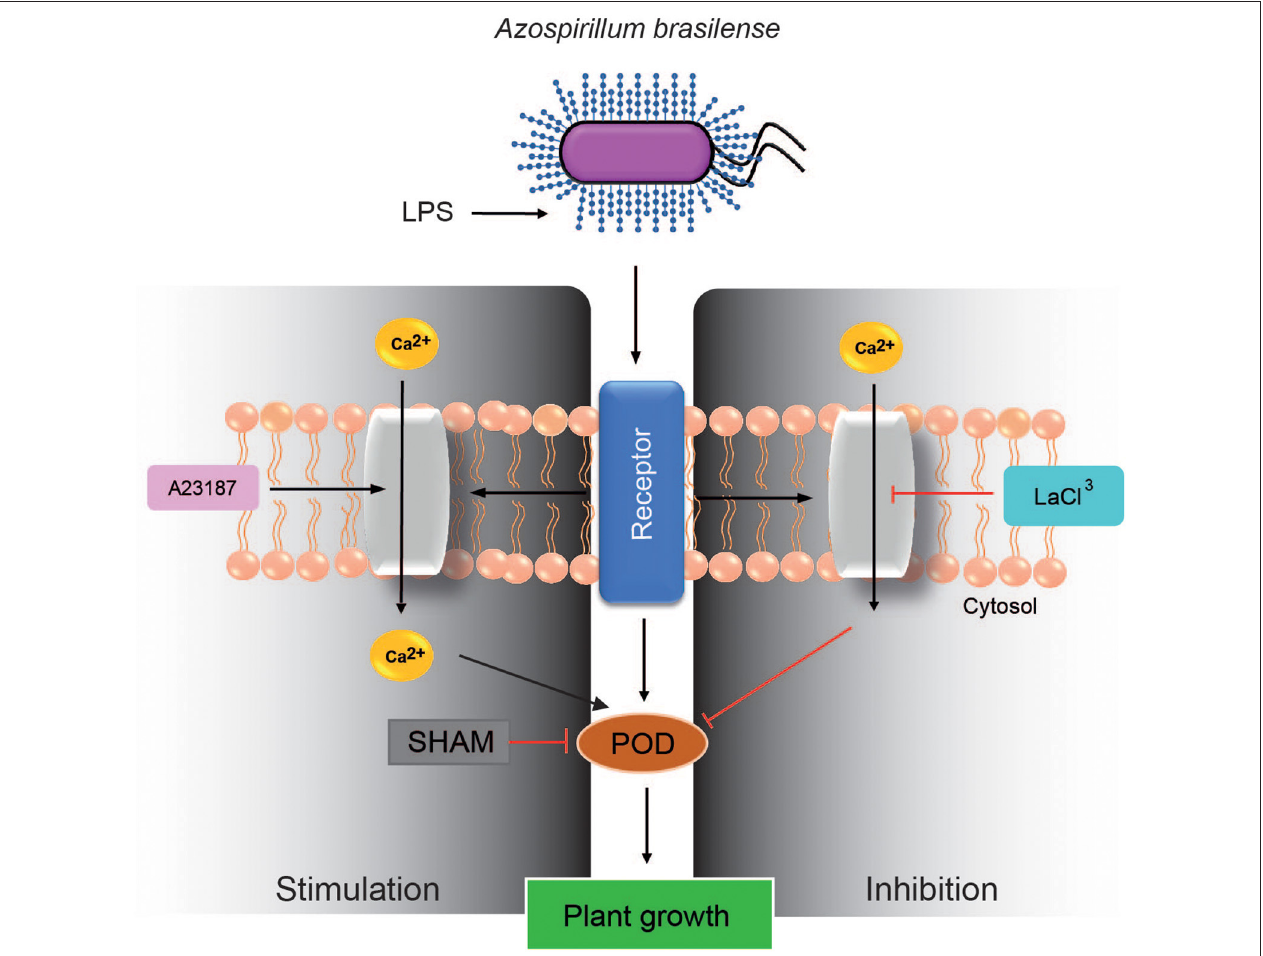
FIGURE 3 | Scheme showing the relationship among LPS, calcium mobilization and POD activity, to regulate plant growth. LPS, lipopolysaccharides; A23187, ionophore A23187; SHAM, salicylhydroxamic acid; POD, peroxidase; LaCl 3 , lanthanum